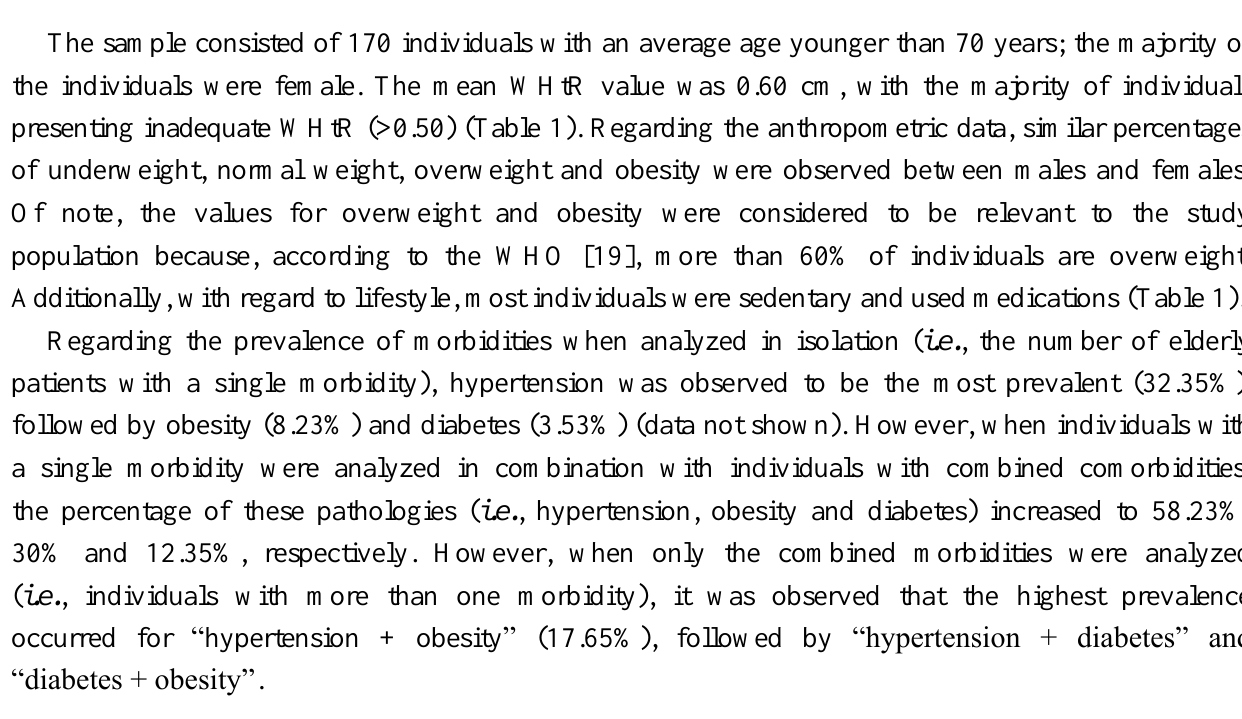
Table 1. Characteristics of the study